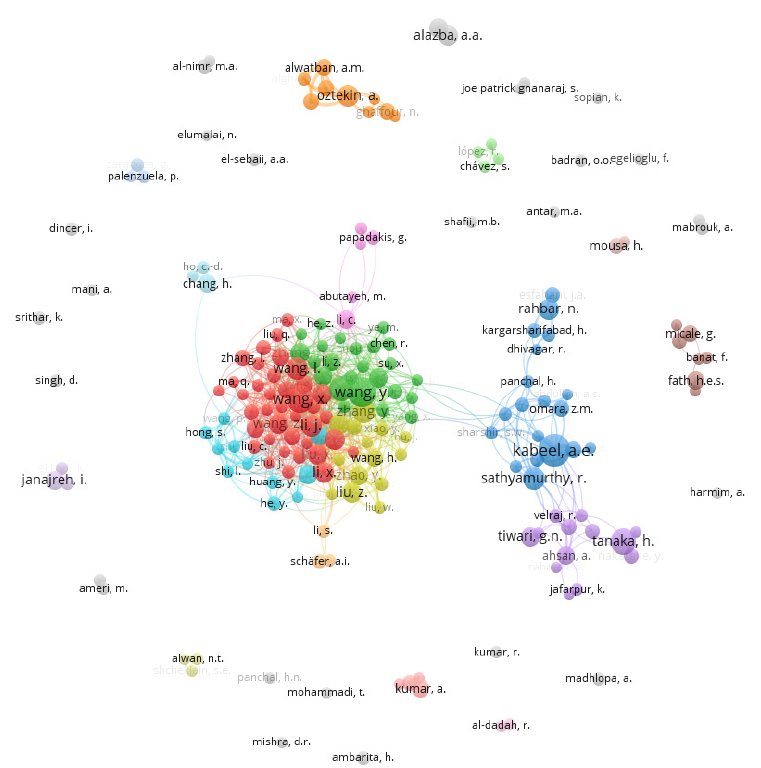
Figure 5. Network analysis diagram based on authors’ collaboration.